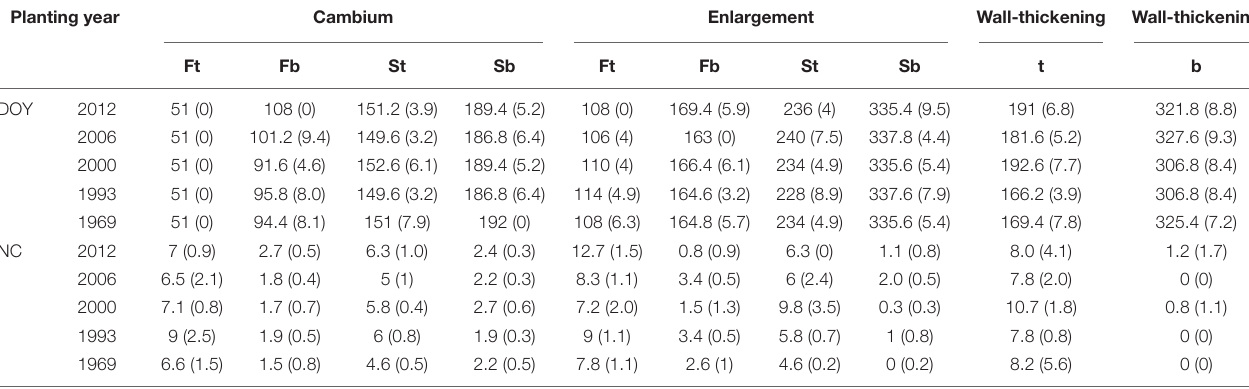
TABLE 3 | Inflection points of different cell stages. Planting year